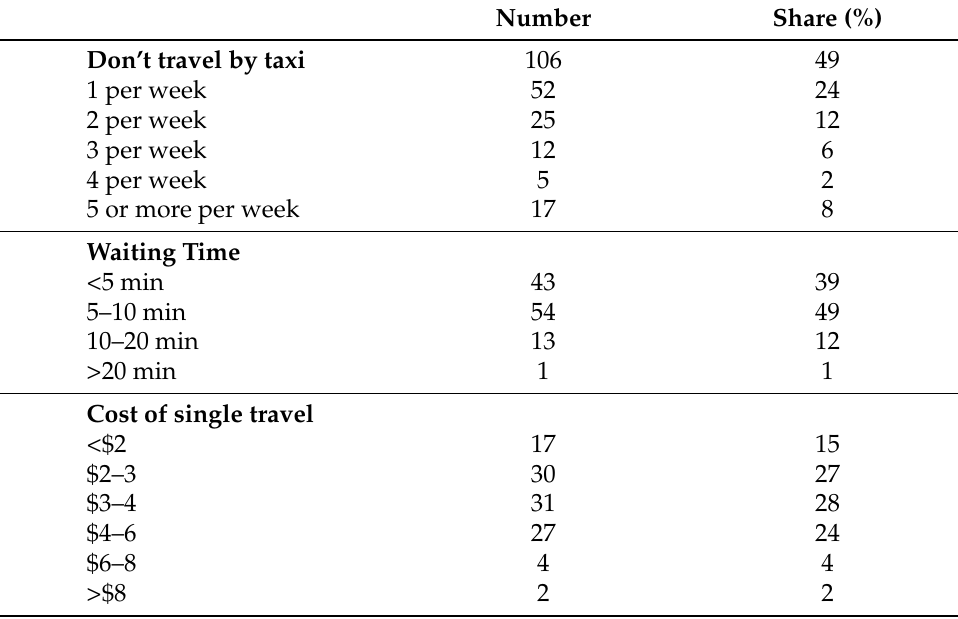
Table 3. Demographic summary of the taxi